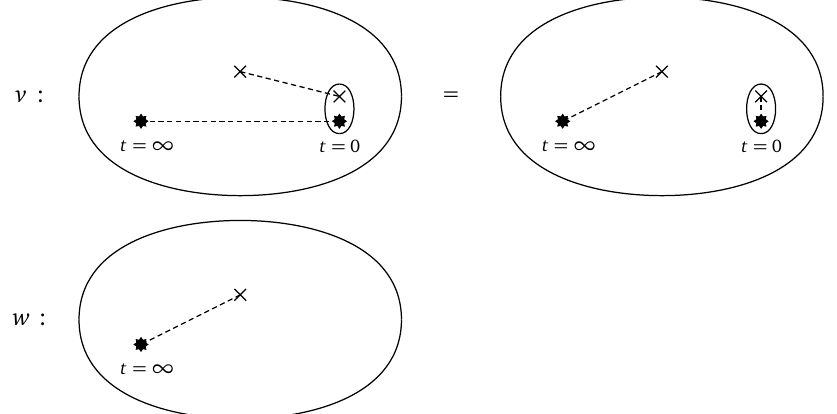
Figure 4: A possible movement and collision of branch points that ensures that the branch structures of v and w curves coincide. However, as explained in the text, this branch structure is not possible.